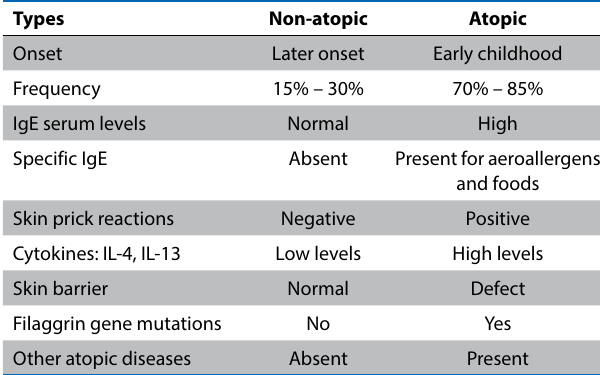
Table 1. Categories of atopic dermatitis 10,11 Types